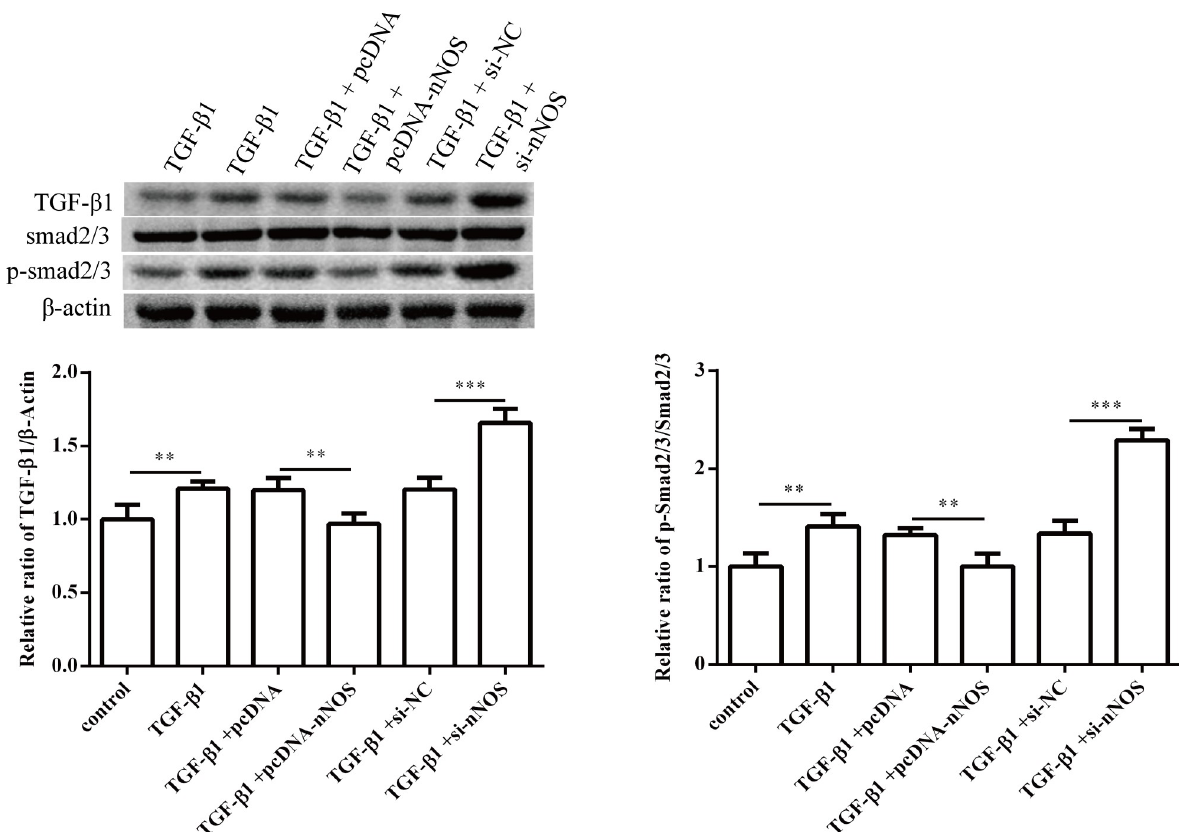
Fig 8. Effects of nNOS on the TGF- β 1/Smad2/3 pathway. All of the data are shown as the mean ± SD. Compared with the control group. n = 3, � P < 0.05; �� P < 0.01; ��� P < 0.001. The analysis is not able to detect small significant differences due to small sample size.